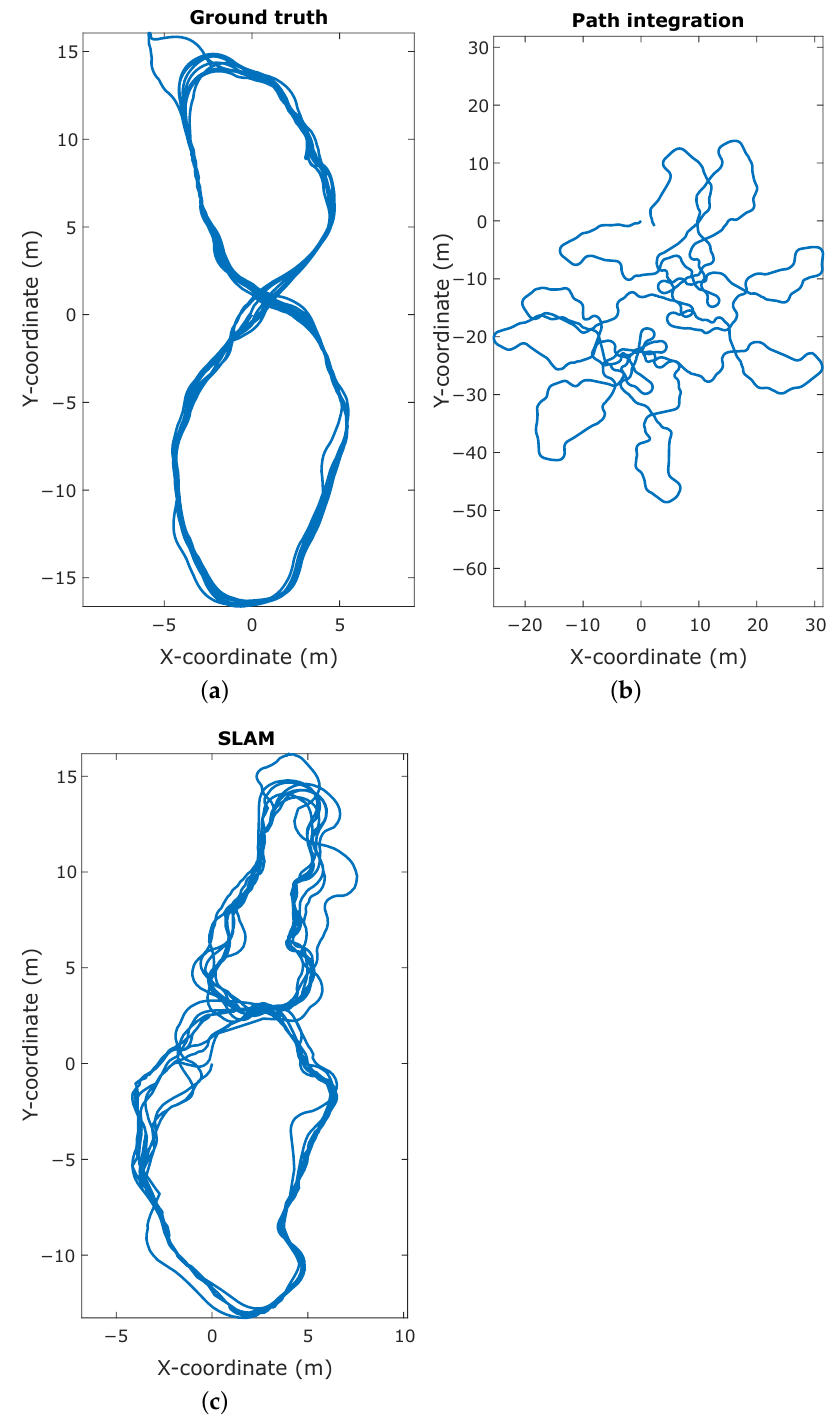
Figure 7. Comparison of the trajectories in the simultaneous localization and mapping experiment. ( a ) The ground truth vehicle trajectory, obtained directly from the simulation engine. ( b ) The tra- jectory as calculated by integrating the velocity commands given to the vehicle. ( c ) The trajectory reconstructed by the simultaneous mapping and localization (SLAM) algorithm, given the velocity inputs and simulated